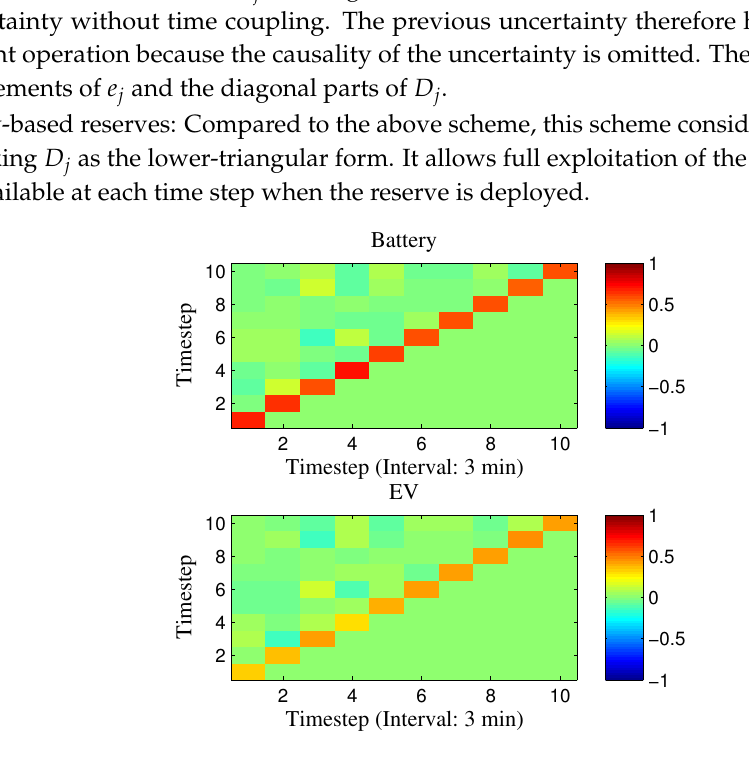
Figure 5. Policy of reserve allocation for one-cell system with time interval of 3